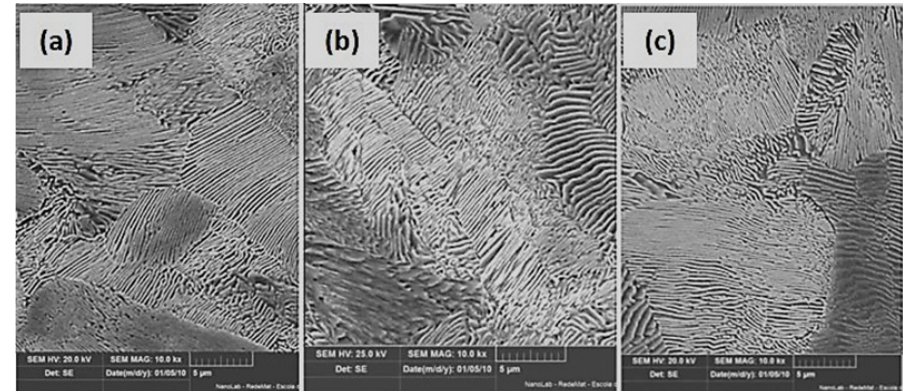
Figure 1. Microstructures of the as manufactured steels: (a) A, (b) B and (c) C - SEM - 10.000X - 2% Nital